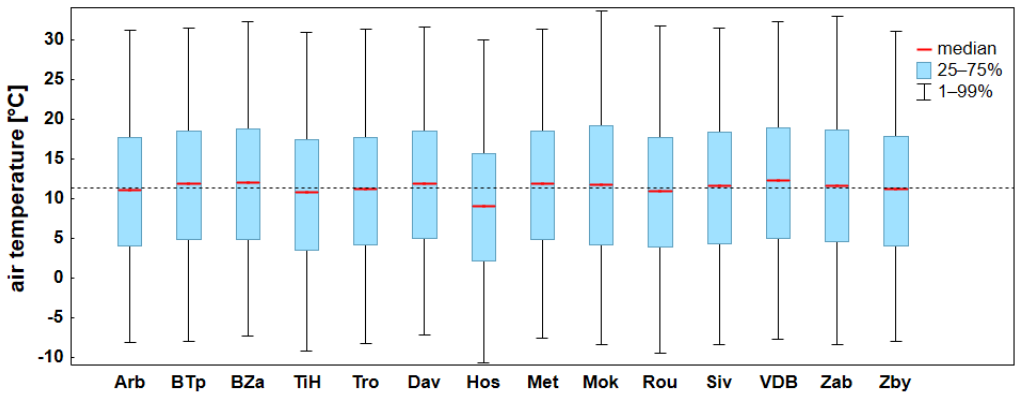
Figure 7. Basic statistical characteristics of air temperature for individual stations in the period 2015–2017 (the dashed line corresponds to the average air temperature of all the stations).